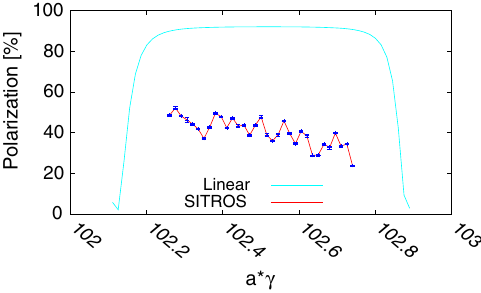
FIG. 7. Polarization vs. spin tune after orbit is corrected with 1096 correctors in presence of BPMs errors with B þ ¼ 3 . 9 T.